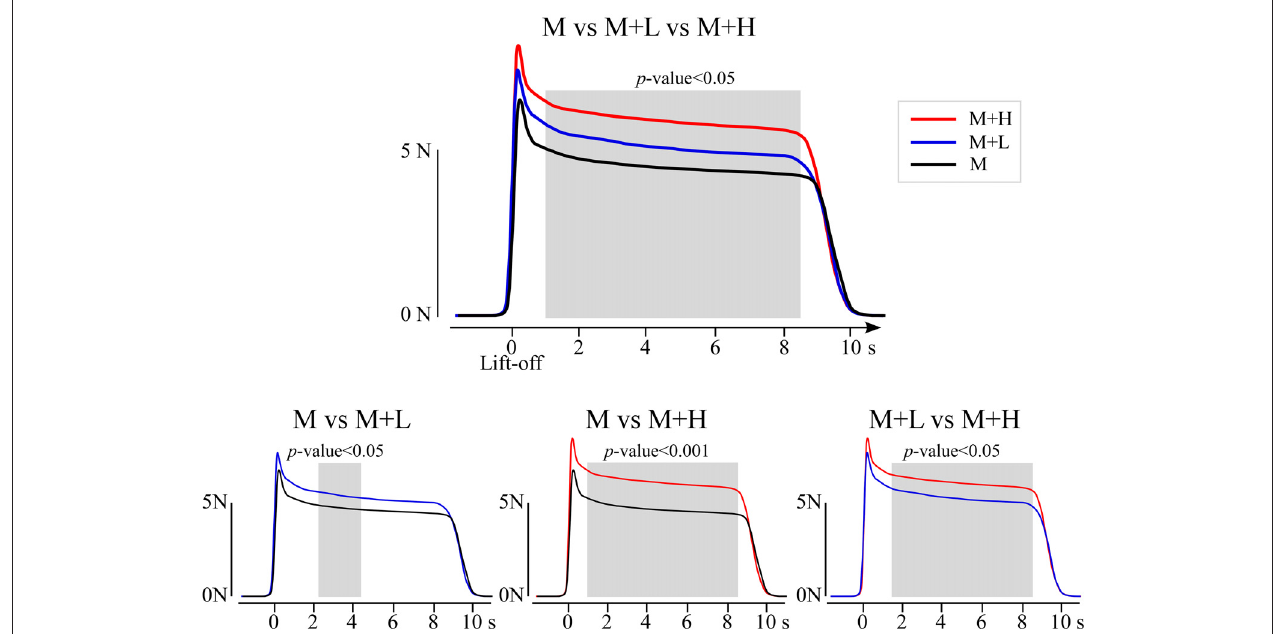
FIGURE 3 | Group-level average waveforms of GF obtained in each of the three conditions, after realigning trials to the lift-off of the object. The waveforms were compared using a point-by-point repeated-measures analysis of variance according to the conditions. This analysis revealed a significant difference across the three conditions extending between 0.98 s and 8.66 s after lift-off. Post hoc point-by-point t-tests showed that GF was greater in the M + L than in the M conditions from 2.25 s to 4.45 s, greater in the M + H than in the M conditions from 0.98 s to 8.64 s, and greater in the M + H than in the M + L conditions from 1.52 s to 8.68